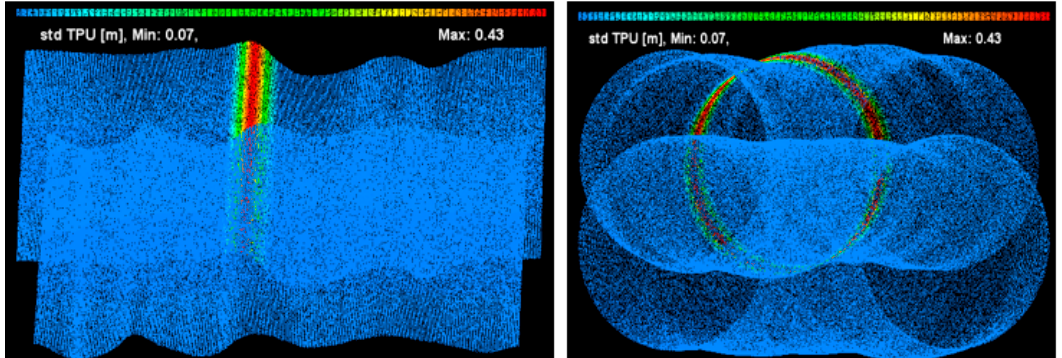
Figure 10. Horizontal TPU with temporary poor position dilution of precision (PDOP) with a linear ( left ) and circular ( right ) scanner.